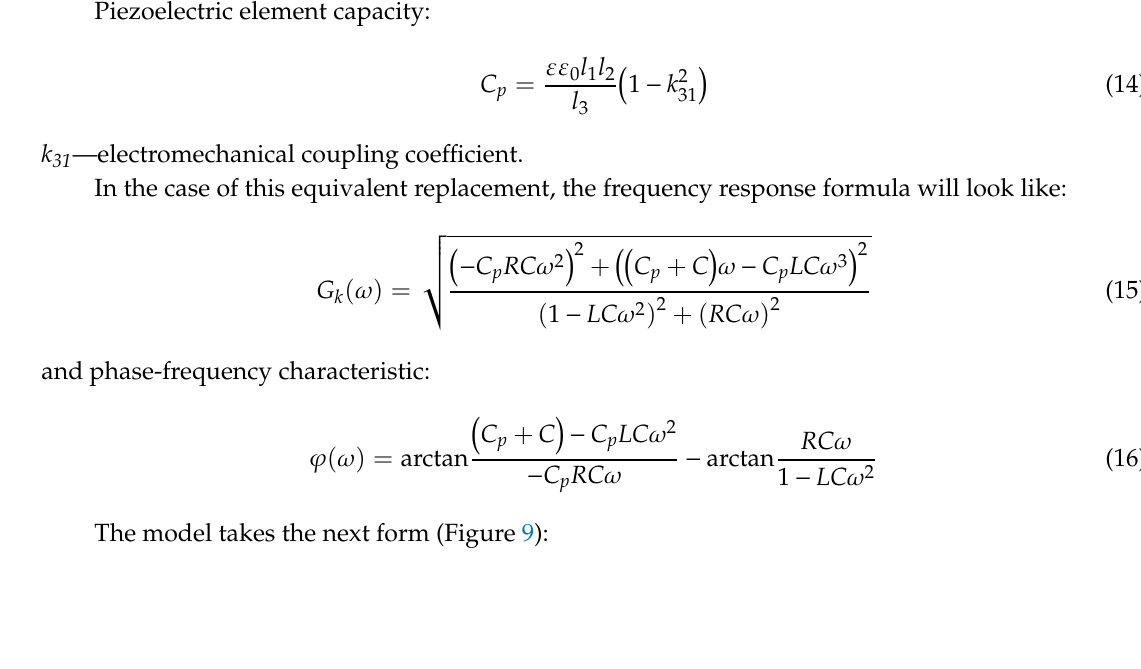
Figure 9. Model after equivalent electromechanical transformations. The complete system dynamics G ck with complete coefficient matrix A ck in this case will look like [17]: for (+) or (−) control: 𝐺 𝑐𝑘 ((𝑛 + 1)ℎ) = 𝑒 𝐴 𝑐𝑘 𝐷ℎ 𝐺 𝑐𝑘 (𝑛ℎ) + 𝐴 −1 (𝑒 𝐴 𝑐𝑘 𝐷ℎ − 𝐼)𝐵